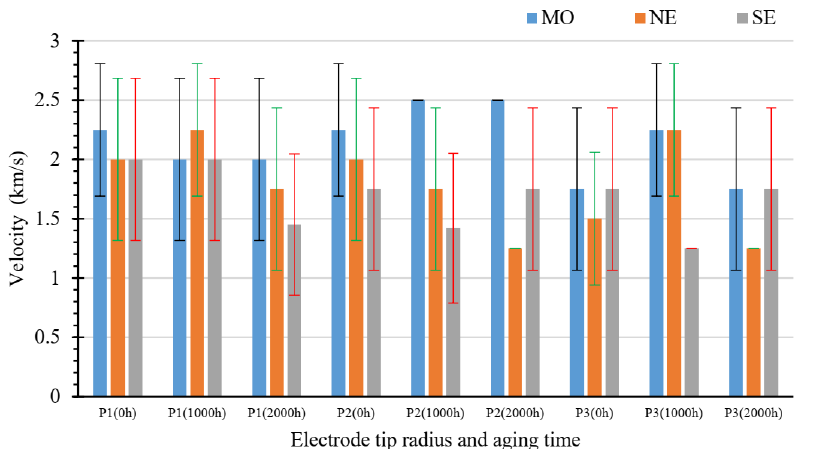
Figure 8. Streamer velocity as a function of electrodes tip radius and aging